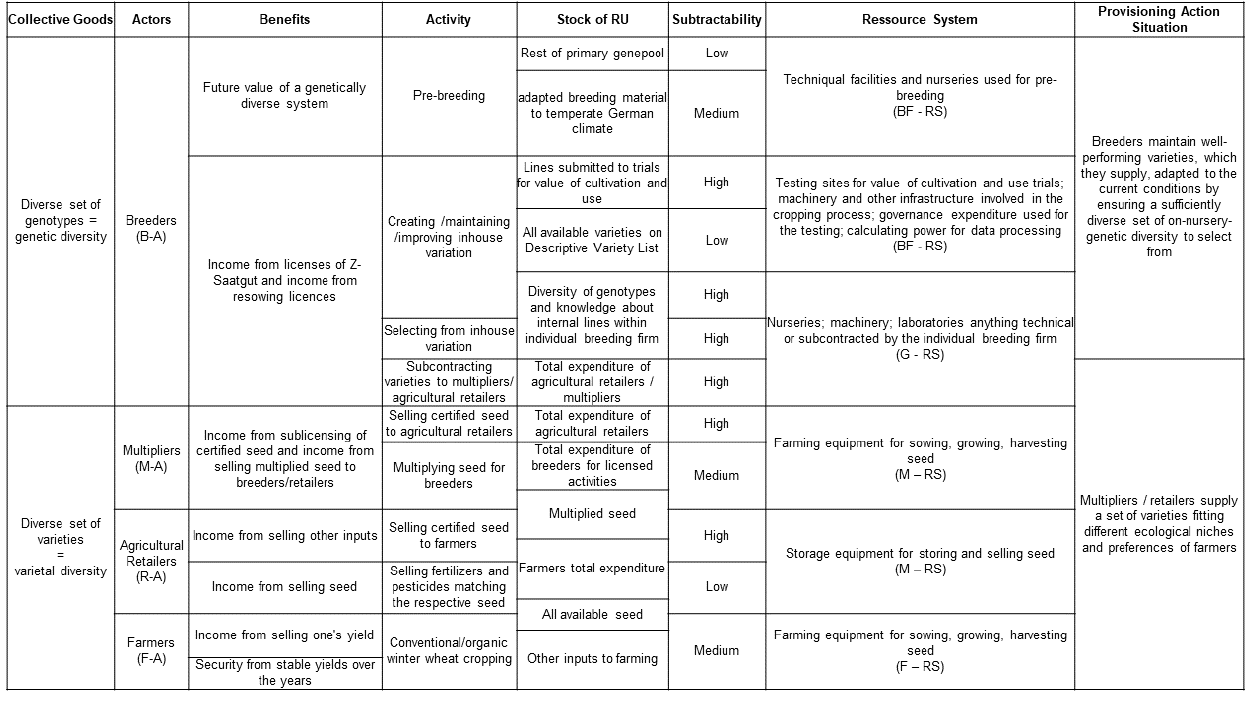
Fig. 5 . Overview of provisioning action situation for seed production of German winter wheat based on the diagnostic procedure from Hinkel et al.